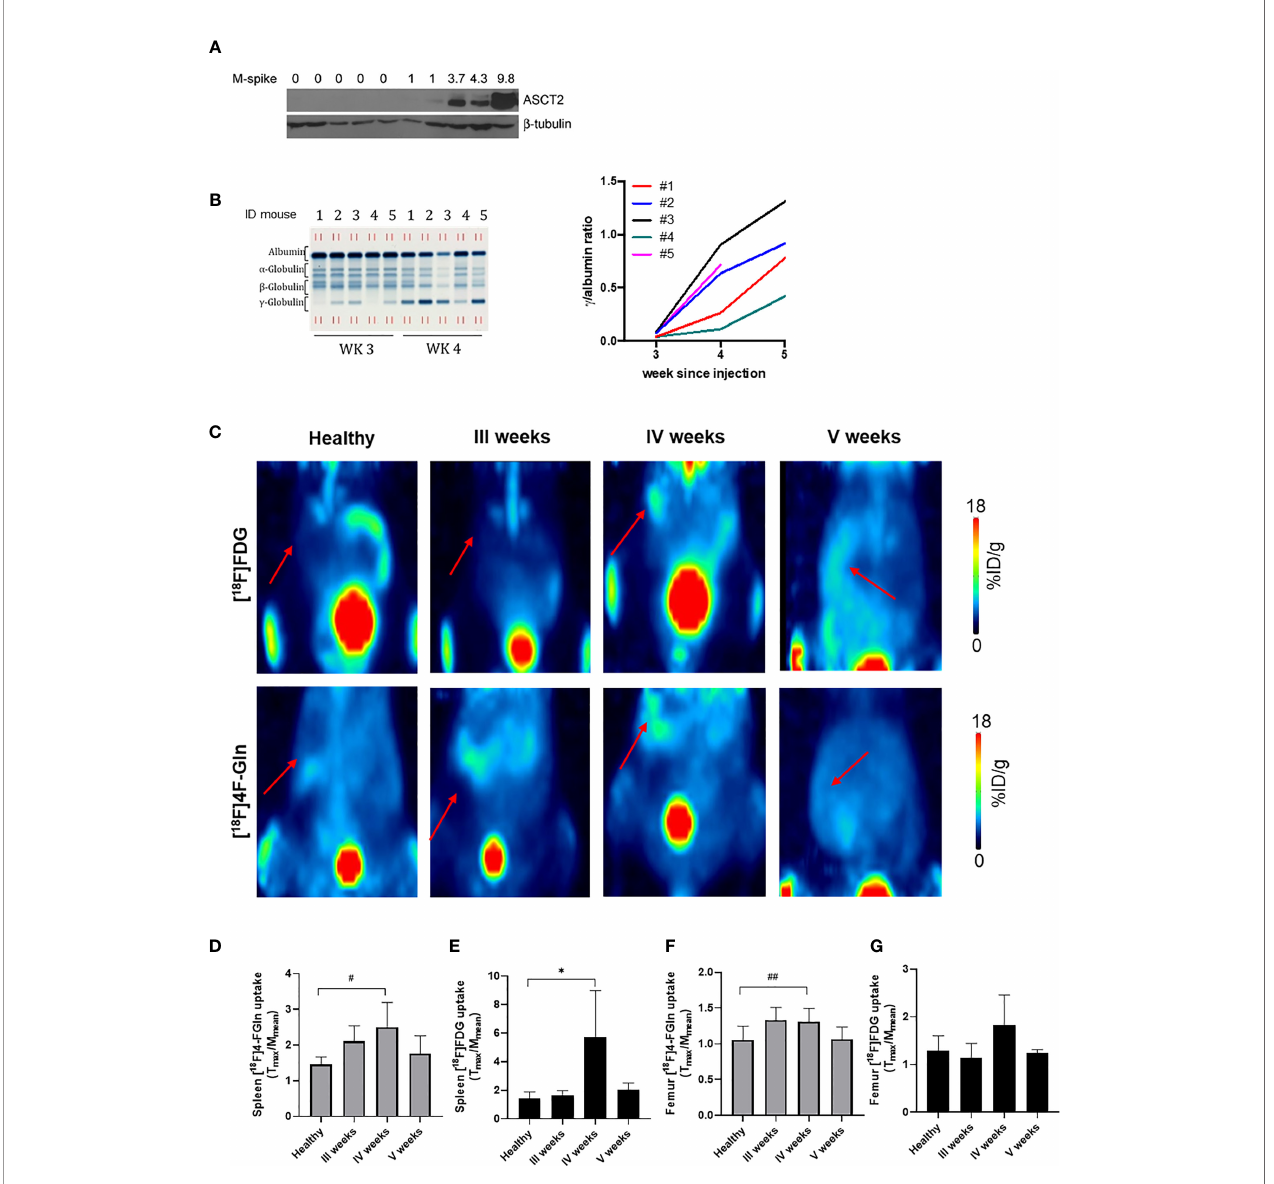
FIGURE 3 | Radiotracers distribution in a syngeneic MM model. (A) ASCT2 expression in the bone marrow (femurs) of control (lanes 1 – 5) and Vk12598 injected mice 5 weeks after injection (lanes 5 – 10). Numbers indicate the M-spike level at the time of the analysis. (B) Representative serum protein electrophoresis gel (left) and tumor growth curves represented as total gamma/albumin ratio (right) of mice from 1 to 5 measured at 3, 4, and 5 weeks after Vk12598 injection. (C) Representative maximum intensity projection (MIP) images of from [ 18 F]FDG and [ 18 F]4-FGln of a healthy mouse and at III, IV, and V weeks from the injection of Vk12598 cells. The red arrows indicate the spleen. (D, E) Quantitative analysis of radiotracers uptake expressed as T/M in the spleen. Differences intragroups were tested for signi fi cance using paired t test. *p = 0.03; # p = 0.04. (F, G) Quantitative analysis of radiotracers uptake expressed as T/M in the femur. Differences intragroups were tested for signi fi cance using paired t test. ## p =